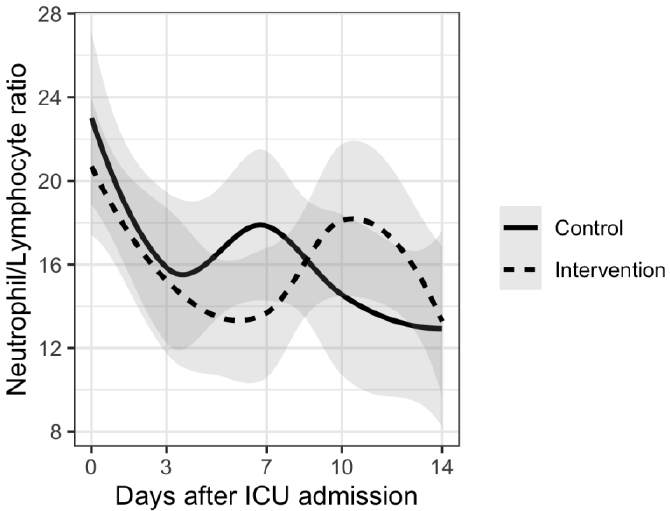
Figure 5. Mean neutrophil/lymphocyte ratio and trends during 14 days from ICU admission.